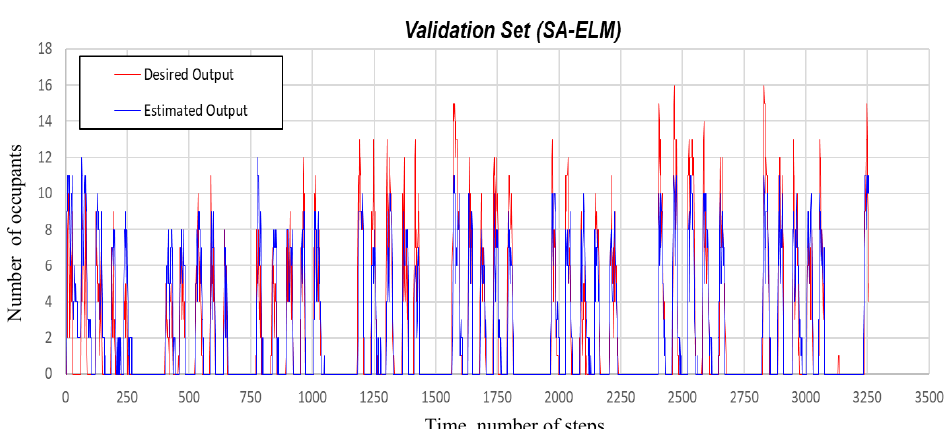
Fig. 6 . SA - ELM model occupancy prediction results based on CO 2 .